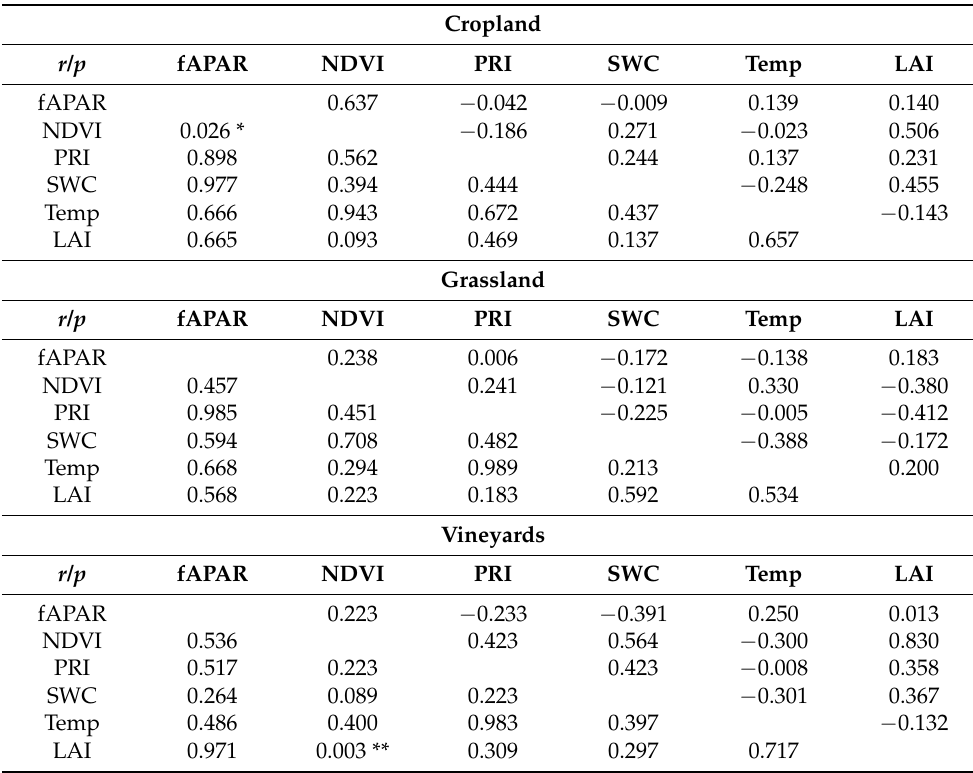
Table 2. Pearson correlation analysis ( r ) and p -value ( p ) between the investigated plant and soil parameters. Correlation is significant * at the 0.05 and ** the 0.01 levels. n = 14. Cropland r / p